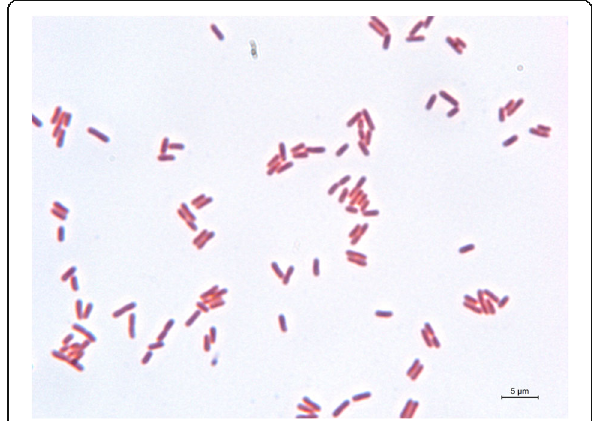
Fig. 1 Photomicrograph of Gram stained exponentially growing Pectobacterium carotovorum SCC1 cells. A light microscope with 100× magnification was used